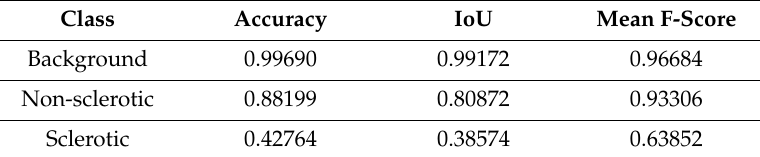
Table 7. Class Metrics Deeplab v3+.